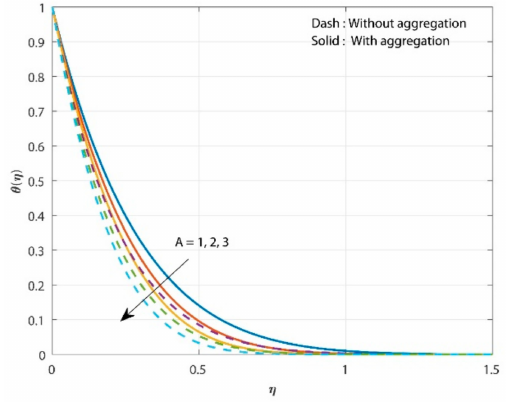
Figure 4. Influence of acceleration parameter on θ .